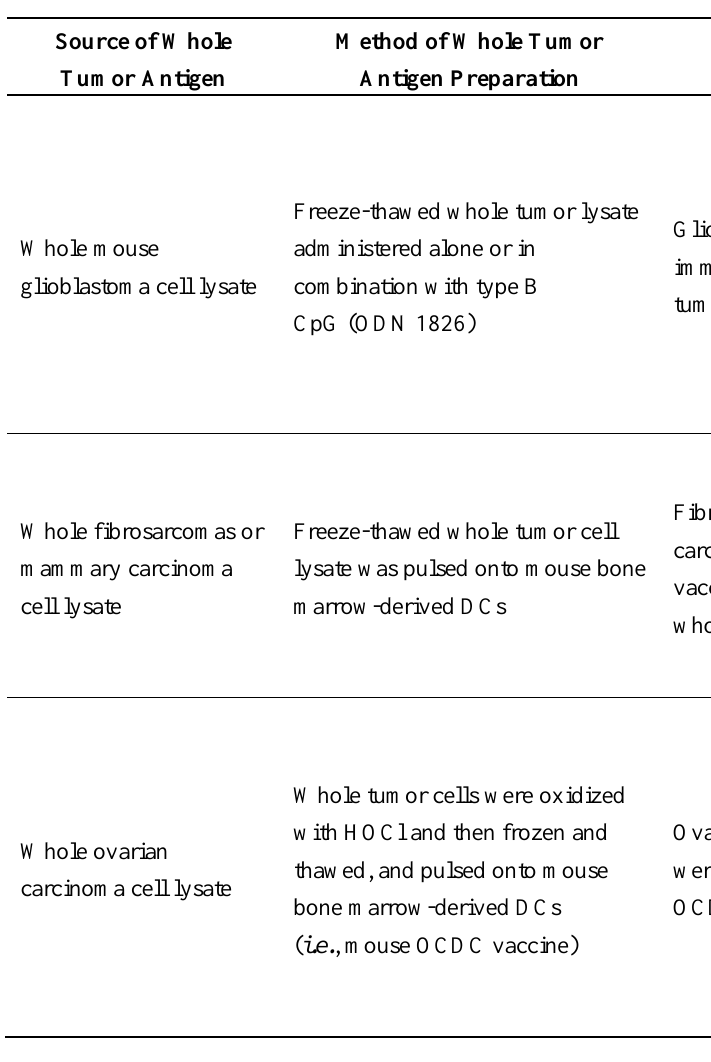
Table 1. Evaluation of different whole tumor antigens in selected preclinical mouse tumor